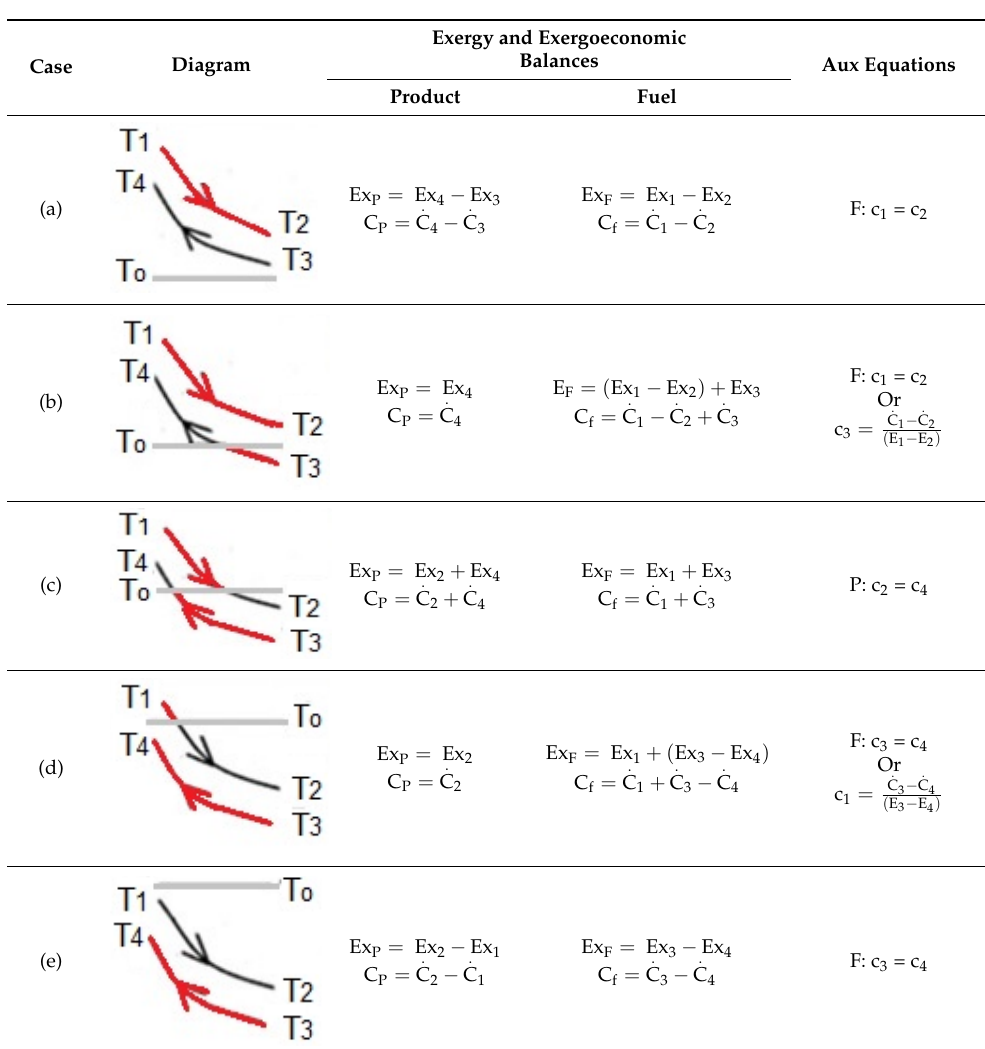
Table 2. SPECO method applied to heat exchangers.